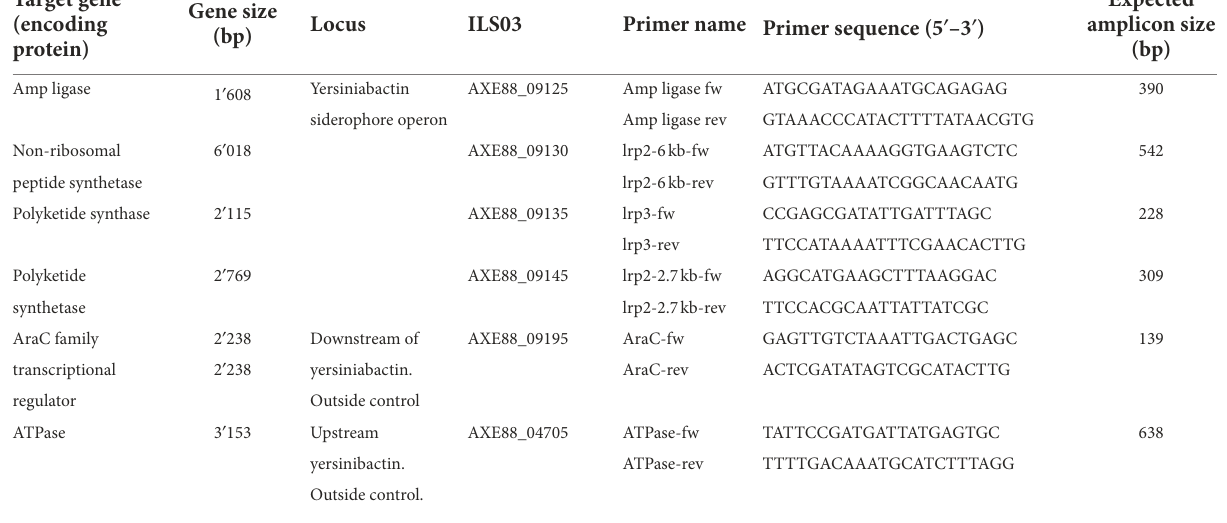
TABLE 2 Primers for yersiniabactin locus detection in S. aureus. Target gene